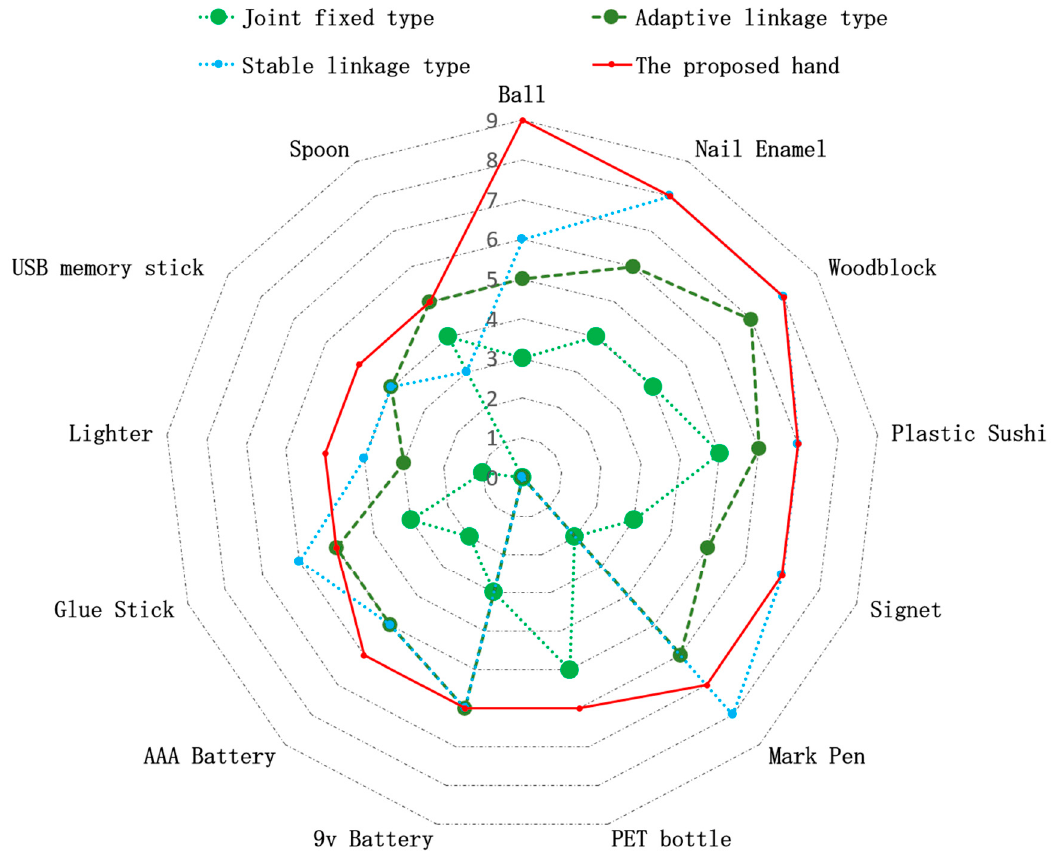
Figure 22. Pick-and-place experimental results. Ten trials for each hand. The result shows the average